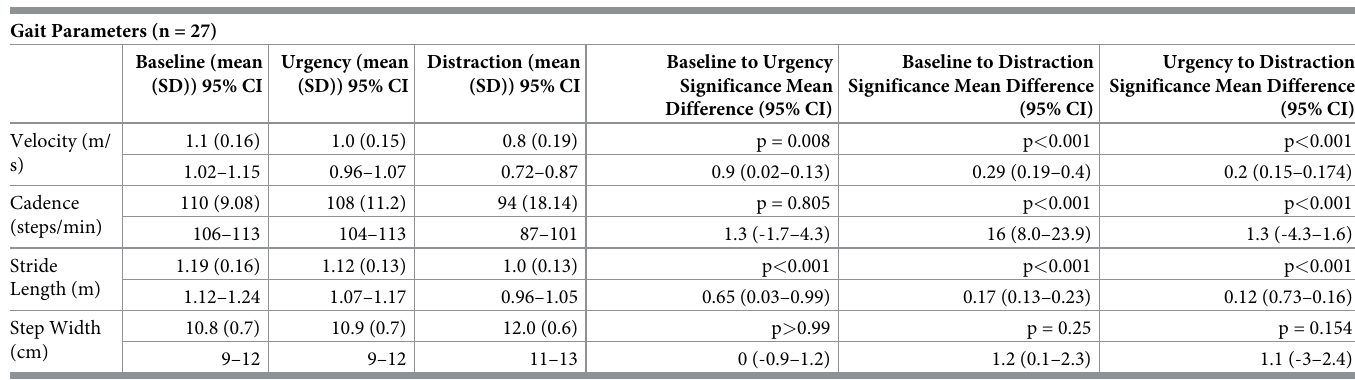
Table 2. Temporal spatial gait analysis.